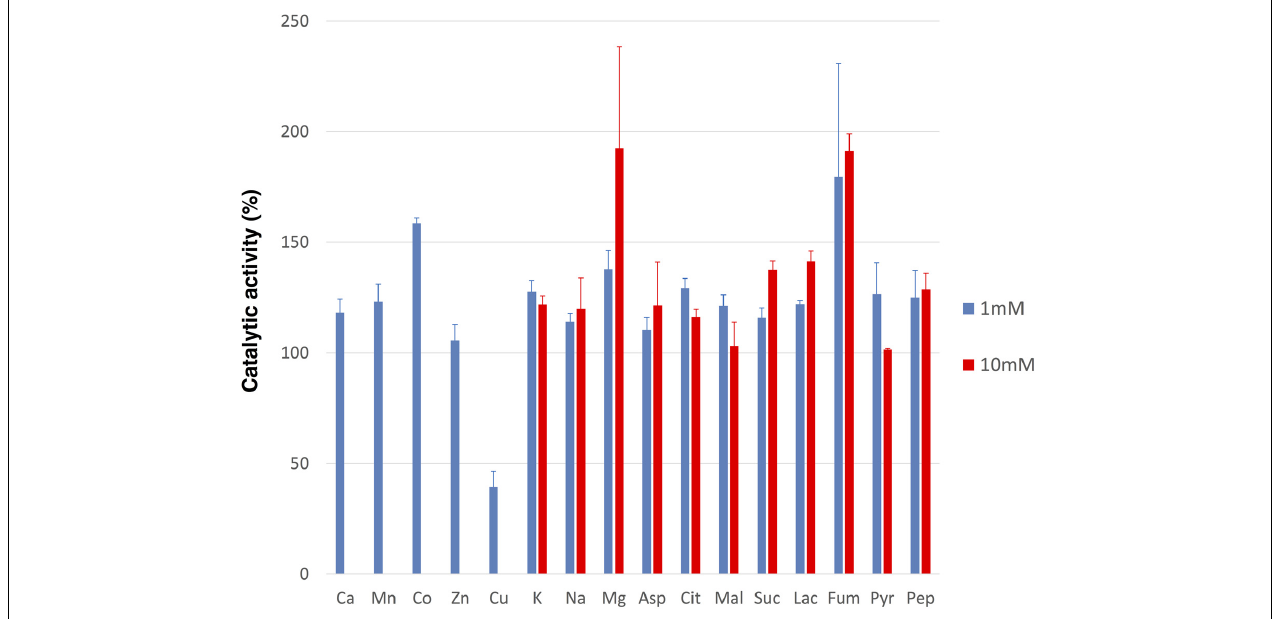
FIGURE 4 | Effects of various metal ions and compounds on the Sy MDH in the reductive reaction in vitro . 10 µ g of Sy MDH was pre-incubated with 100 mM potassium phosphate (pH 6.5), 0.1 mM NADH, 0.1 mM oxaloacetate and effectors, at 45 ◦ C. The graphs show the mean ± SD obtained from three independent experiments. Activity of Sy MDH in the absence of effectors was set at 100%. Ca, CaCl 2 ; Mn, MnCl 2 · 4H 2 O; Co, Co(NO 3 ) 2 · 6H 2 O; Zn, ZnSO 4 · 7H 2 O; Cu, CuSO